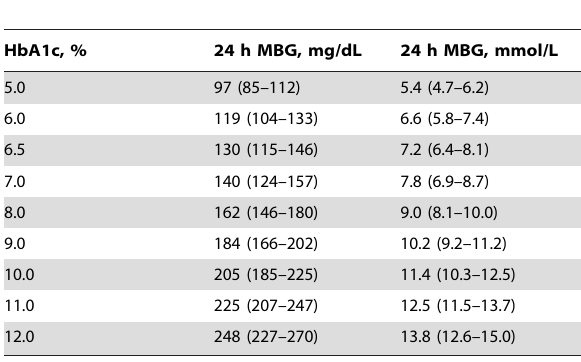
Table 4. The 24 h MBG levels estimated by linear regression for various HbA1c levels (95% CI, n